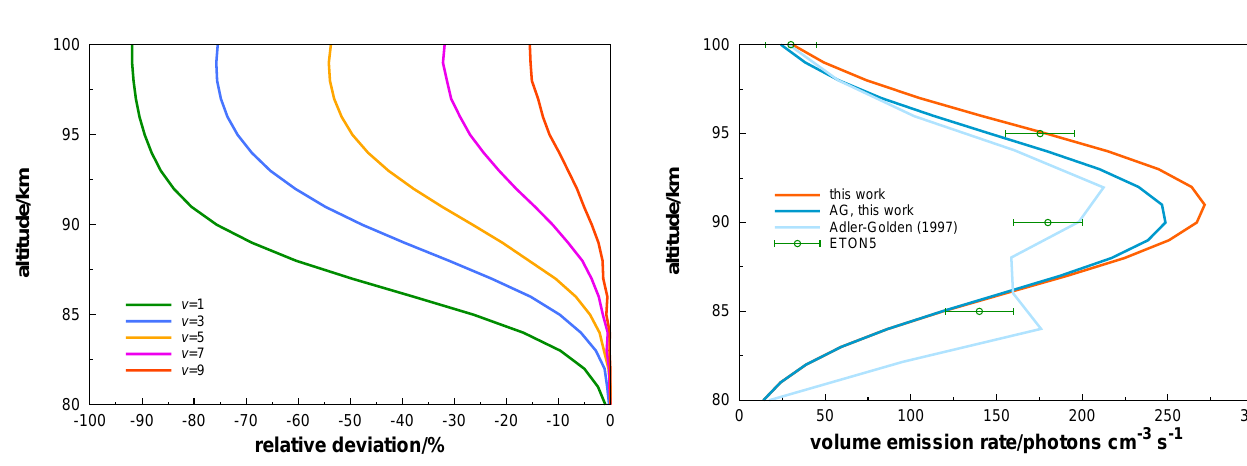
Fig. 4. Vertical profiles of vibrationally excited hydroxyl radical: (a) using the Adler-Golden (1997) O + OH ( v ) total rate constant; (b) Adler-Golden scheme revisited using the total rate constant from the current work; (c) McDade and Llewellyn (1987) ‘sudden-death’ and (d) collisional cascade mechanisms.